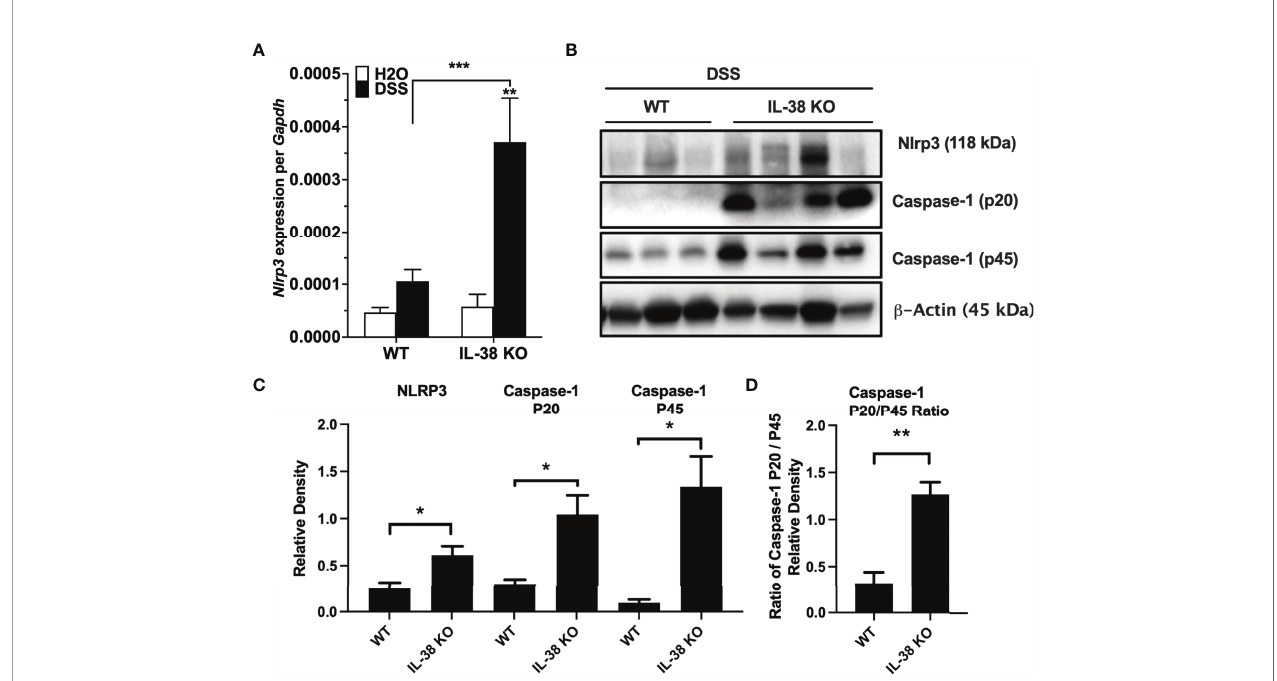
FIGURE 4 | Endogenous IL-38 inhibits NLRP3 activation in colitis. WT and IL-38 KO (IL-38 de fi cient) mice subjected to DSS. (A) mRNA expression of Nlrp3 in colonic tissue measured by qPCR, normalized to GAPDH. (B) NLRP3, Caspase-1 (p20), Caspase-1 (p45) and b -Actin protein abundance in colonic tissues quanti fi ed by Western Blot analysis. Lanes 1-3 contain colonic tissue of WT mice treated with DSS, lanes 4-7 from IL-38 de fi cient mice subjected to DSS. A representative blot is shown from two experiments with 3-4 mice per group. (C) Quanti fi cations of blots presented in (B) . (D) P45/p20 ratio in WT mice treated with DSS compared to IL-38 KO mice. The data represents the mean ± SEM, *P < 0.05, **P < 0.01, ***P < 0.001, by two-way ANOVA with Fisher ’ s multiple comparison in (A) , and student ’ s T-test in (C, D)